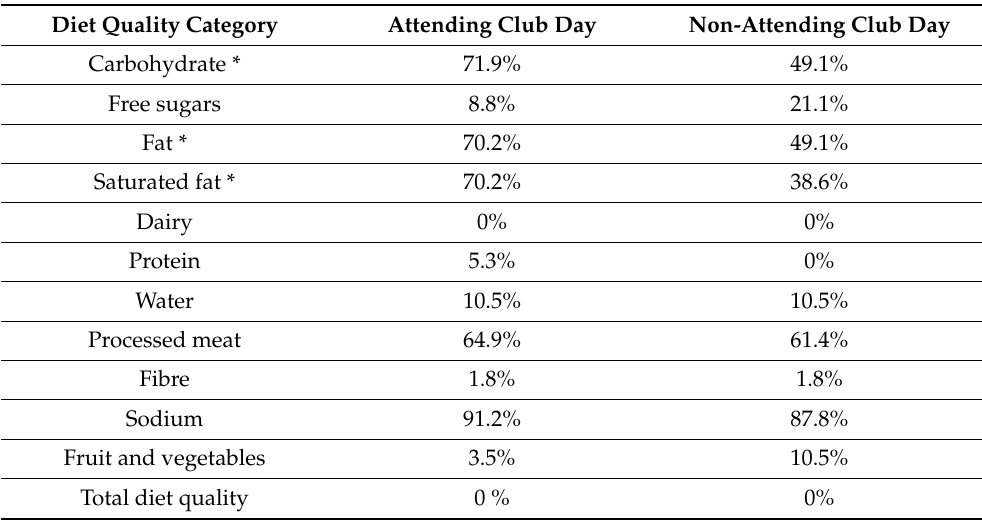
Table 4. The percentage of children meeting dietary recommendations on attending and non- attending days. Statistically significant differences ( p < 0.05) are highlighted with *.